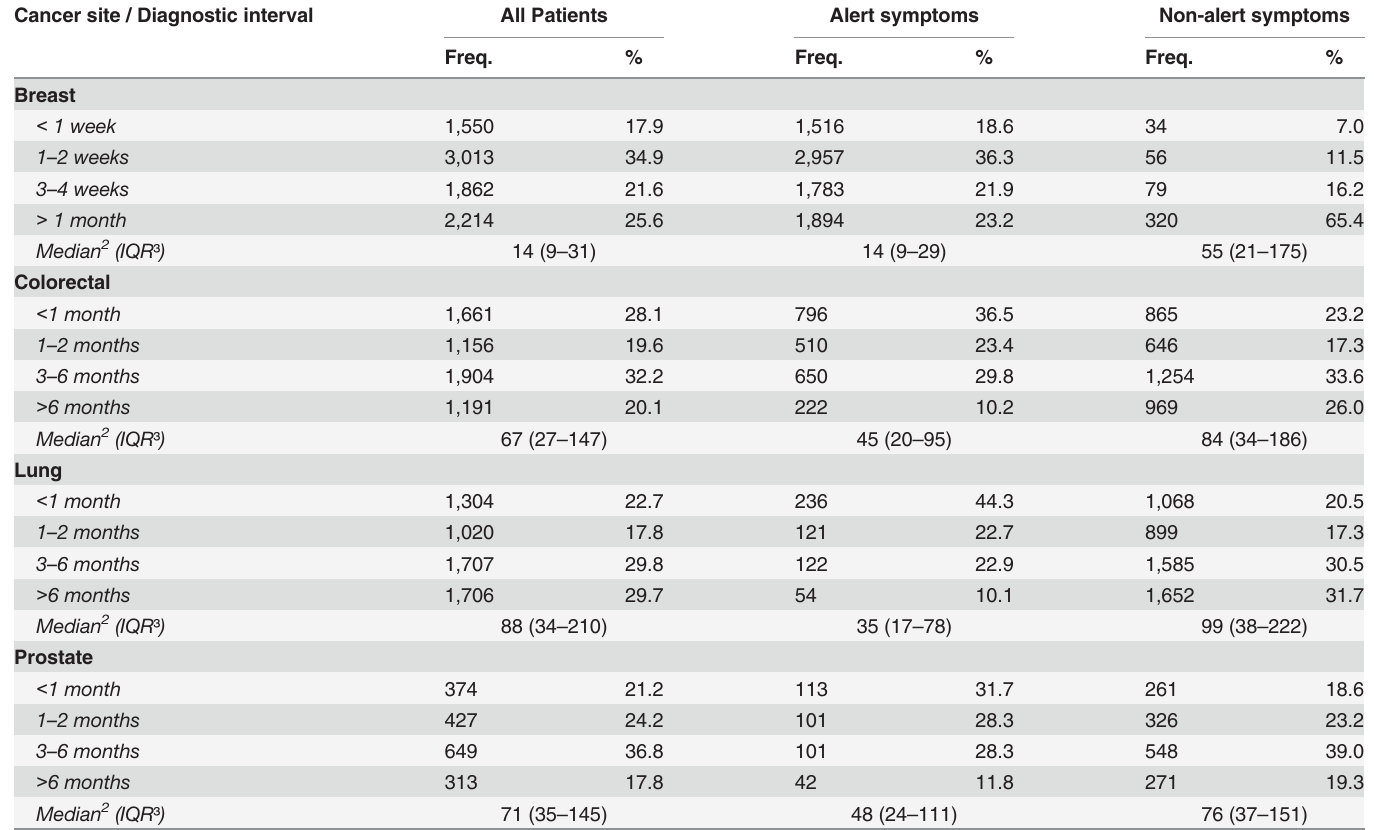
Table 3. Characteristics of patients by diagnostic interval ¹ , symptom category and cancer